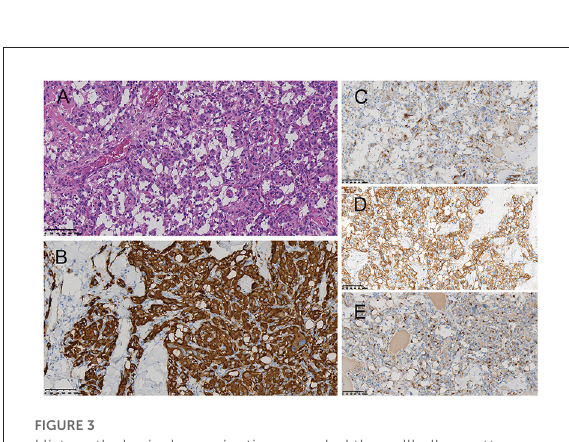
FIGURE3 Histopathological examination revealed the zellballen pattern characteristic of paraganglioma (A) . Immunohistochemical results were positive for synaptophysin (B) , chromogranin A (C) , and CD56 (D) in the tumor cells and S-100 protein in the supporting cells (E)